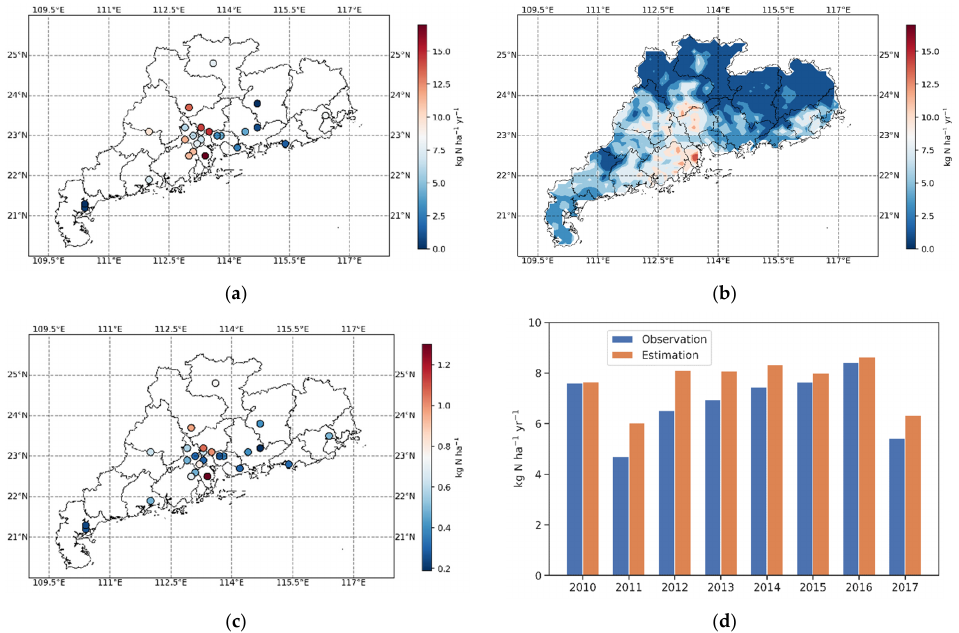
Figure 7. Spatiotemporal distribution of nitrate wet flux: ( a ) annual mean observation; ( b ) annual mean estimation; ( c ) RMSE distribution; ( d ) annual variation between observations and estimation.